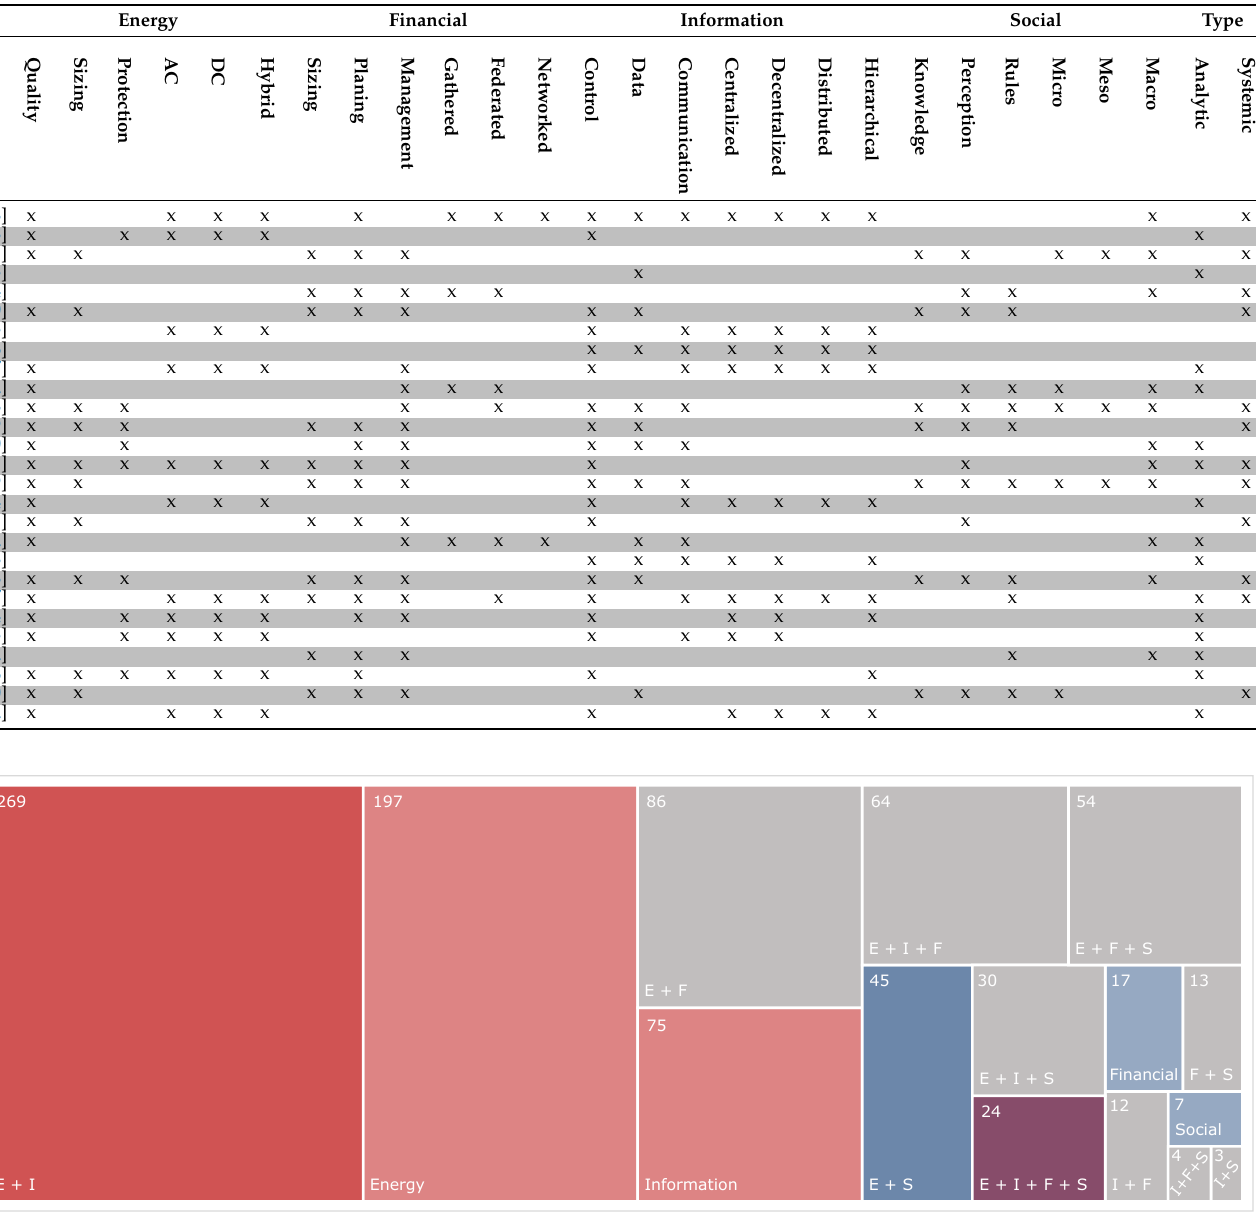
Figure 3. Sustainability and resilience microgrid publications related to the field they